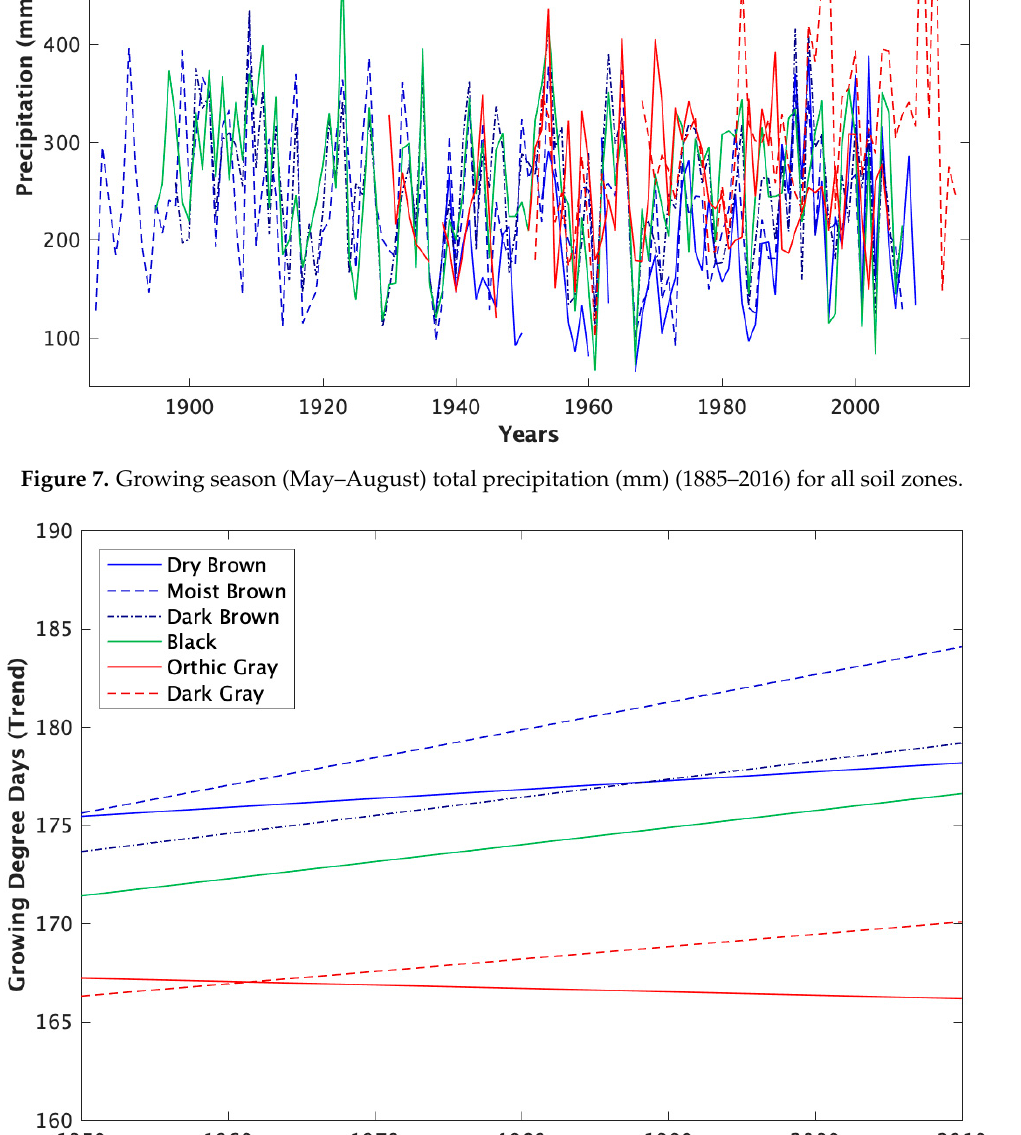
Figure 8. Growing degree days (GDDs) trend (1950–2010) for all soil zones.